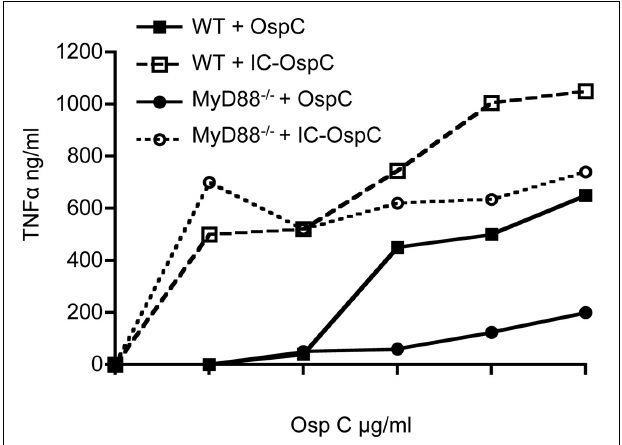
FIGURE 1 | TNF α secretion by macrophages stimulated with OspC and OspC-immune complexes. Peritoneal macrophages from naïve WT and MyD88 − / − mice were stimulated in vitro with recombinant B. burgdorferi OspC protein or OspC-anti-OspC immune complexes for 24h. The levels of secreted TNF α in the supernatants were measured by ELISA. FC γ R DEFICIENCY TRANSIENTLY INCREASES PATHOGEN BURDENS